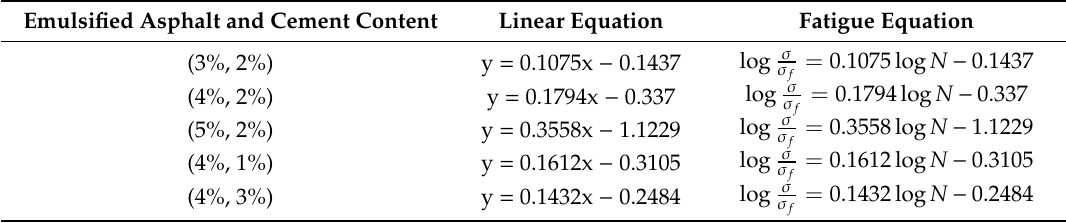
Figure 5. Logarithm of fatigue life with different parameters. ( a ) (3,2) Fatigue equation; ( b ) (4,2) fatigue equation; ( c ) (4,1) fatigue equation; ( d ) (4,3) fatigue equation; ( e ) (5,2) fatigue equation. Table 8. Fatigue equations for di ff erent asphalt and cement